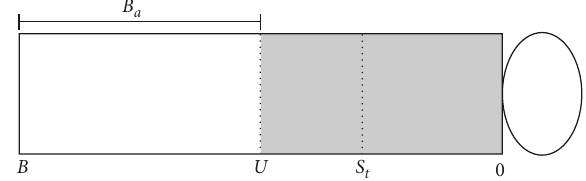
Figure 2: Key parameters used by the EWT shown in a memory size of B